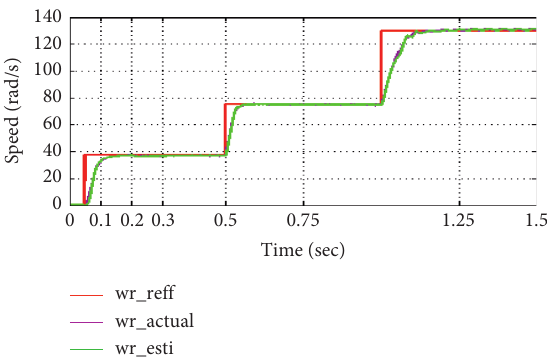
Figure 16: 50% increase of R s from its nominal value for different rotor speeds.